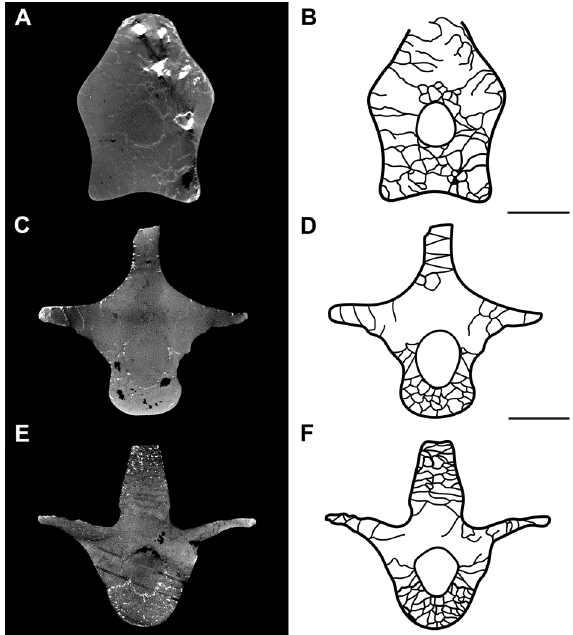
Figure 3. The internal architecture of trabeculae in the mid-length of the vertebrae . Slices of the scans and interpretative drawings of the mid-length of the seventh cervical vertebra ( A, B ) and second ( C, D ) and fourth ( E, F ) dorsal vertebrae of SNSB/BSPG 1991 I 27. Trabeculae and cortical bone are in black in the drawings. Scale bar: 10 mm.